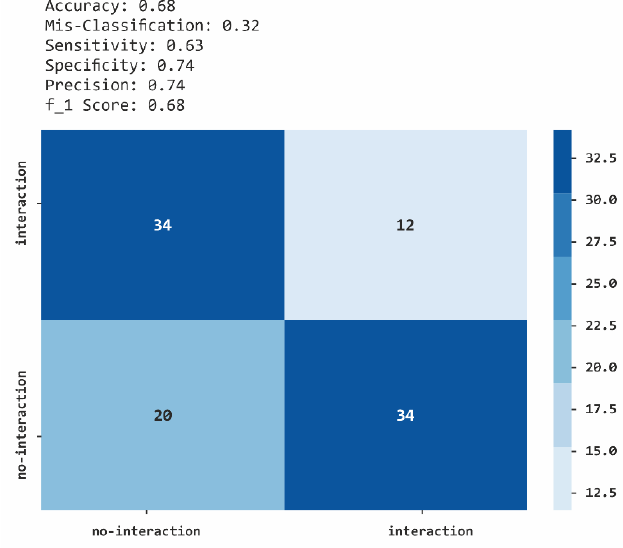
Figure 5.4. Confusion Matrix for threshold value